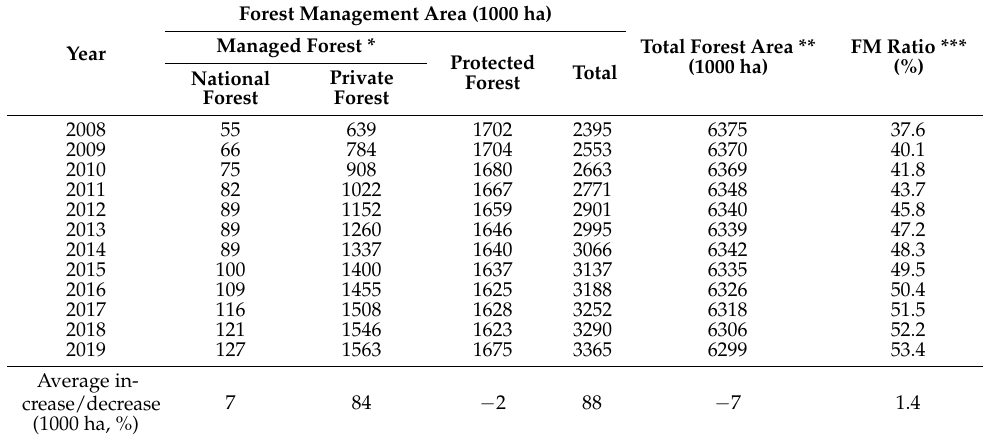
Table 3. Changes in forest management area and ratio by year from 2008 to